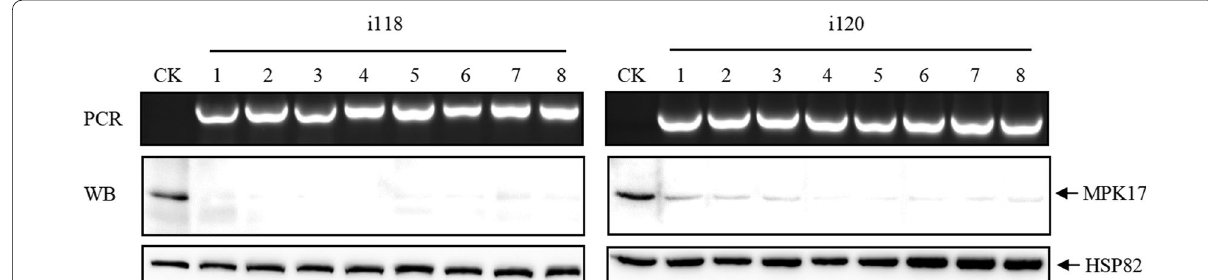
Fig. 2 Identification of MPK17-RNAi transgenic lines by PCR and WB. i118, i120: independent MPK17-RNAi transgenic lines; CK: 4021 (homozygous TP309 transgenic line harboring the Xa21 gene); 1–8: individual transgenic plants in T 3 generation; PCR: PCR genotyping results done with primers (5’-GAG TCG TAA GAG ACT CTG TATG-3’ and 5’- GCG AGC TCG GTT TTC AGT TGA GCA AC-3’). MPK17: anti-MPK17 antibody-detected band; HSP82: